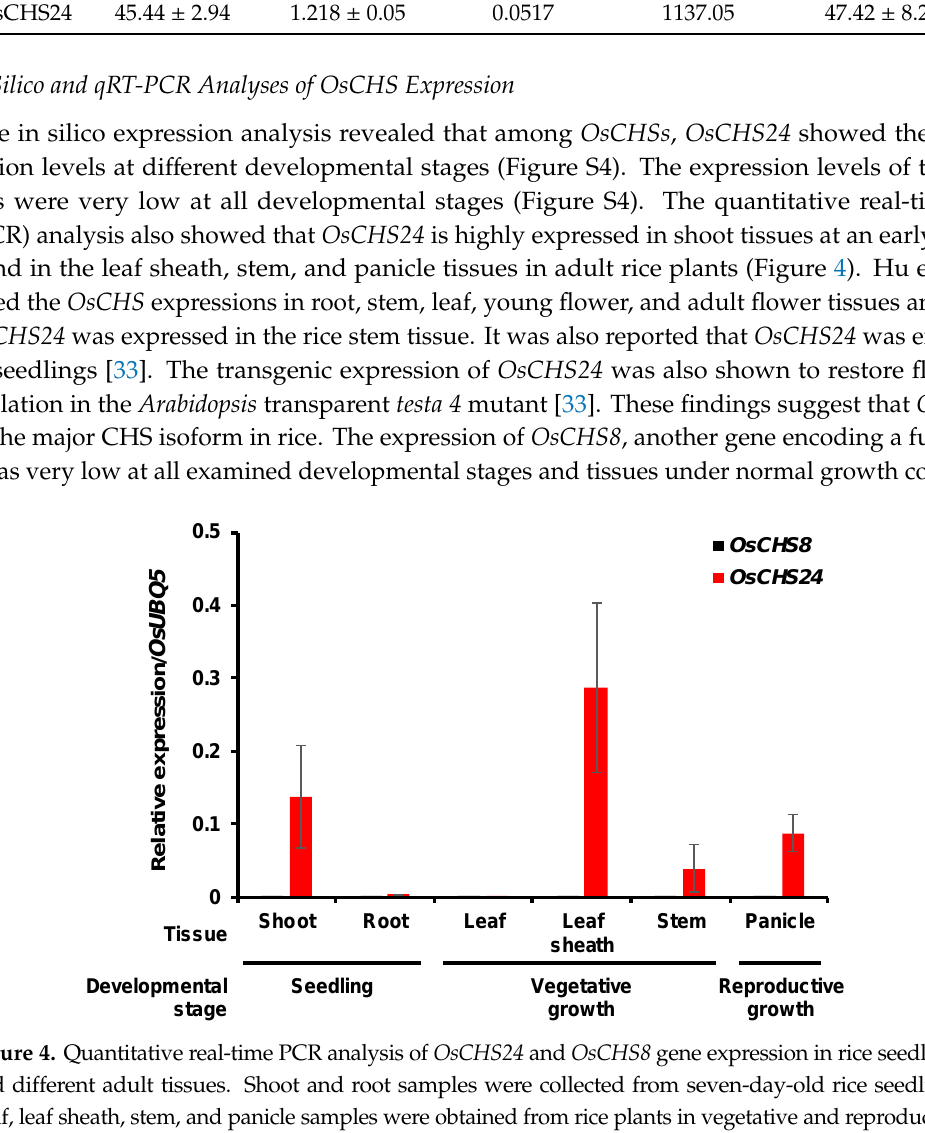
Table 2. Steady-state kinetic parameters of recombinant OsCHS24 and OsCHS8